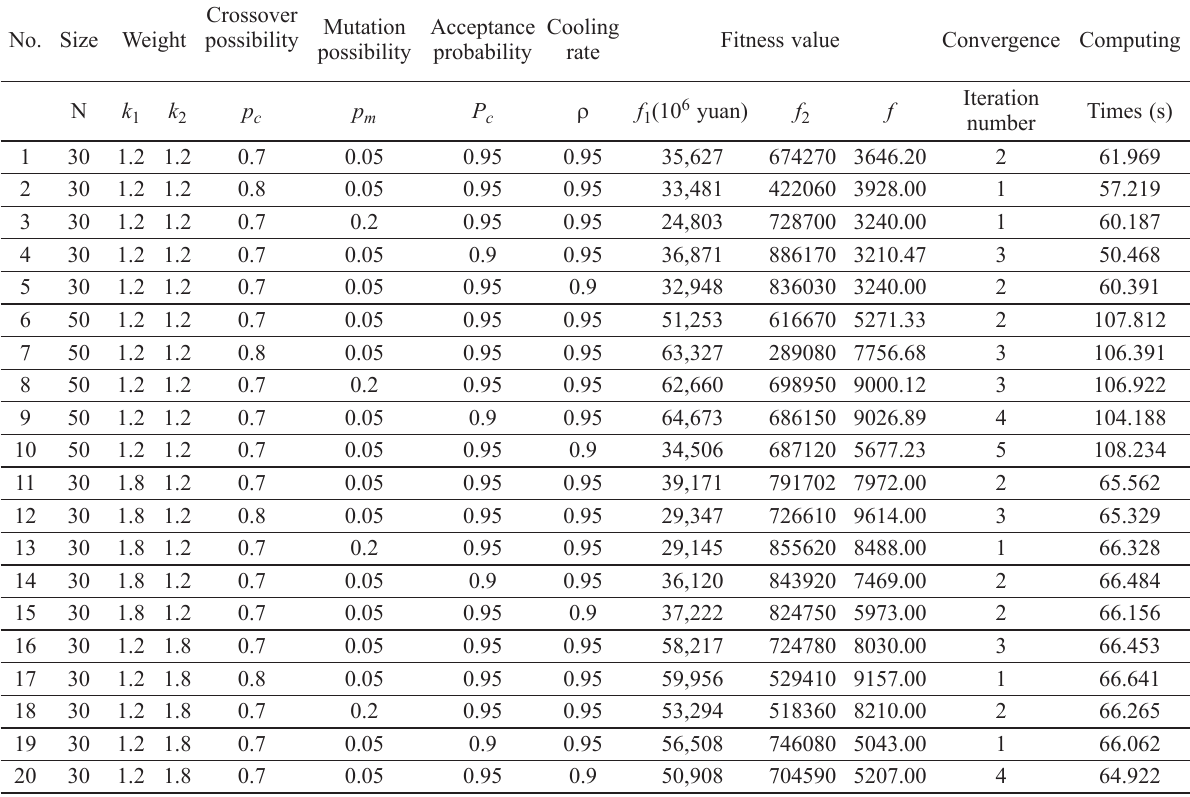
Crossover Mutation Acceptance Cooling possibility possibility probability